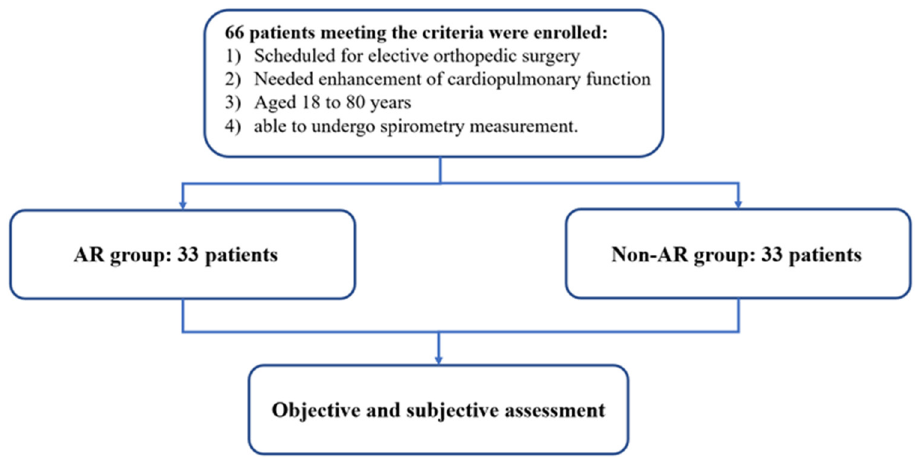
Figure 1. Flowchart of the recruitment of patients. Here, 66 patients were enrolled who met the following criteria: (1) scheduled for elective orthopedic surgery, (2) needed enhancement of cardiopul- monary function, (3) aged 18 to 80 years, and (4) able to undergo spirometry measurement. They were allocated to one of two groups (AR group and non-AR group) with 1:1 non-randomization.